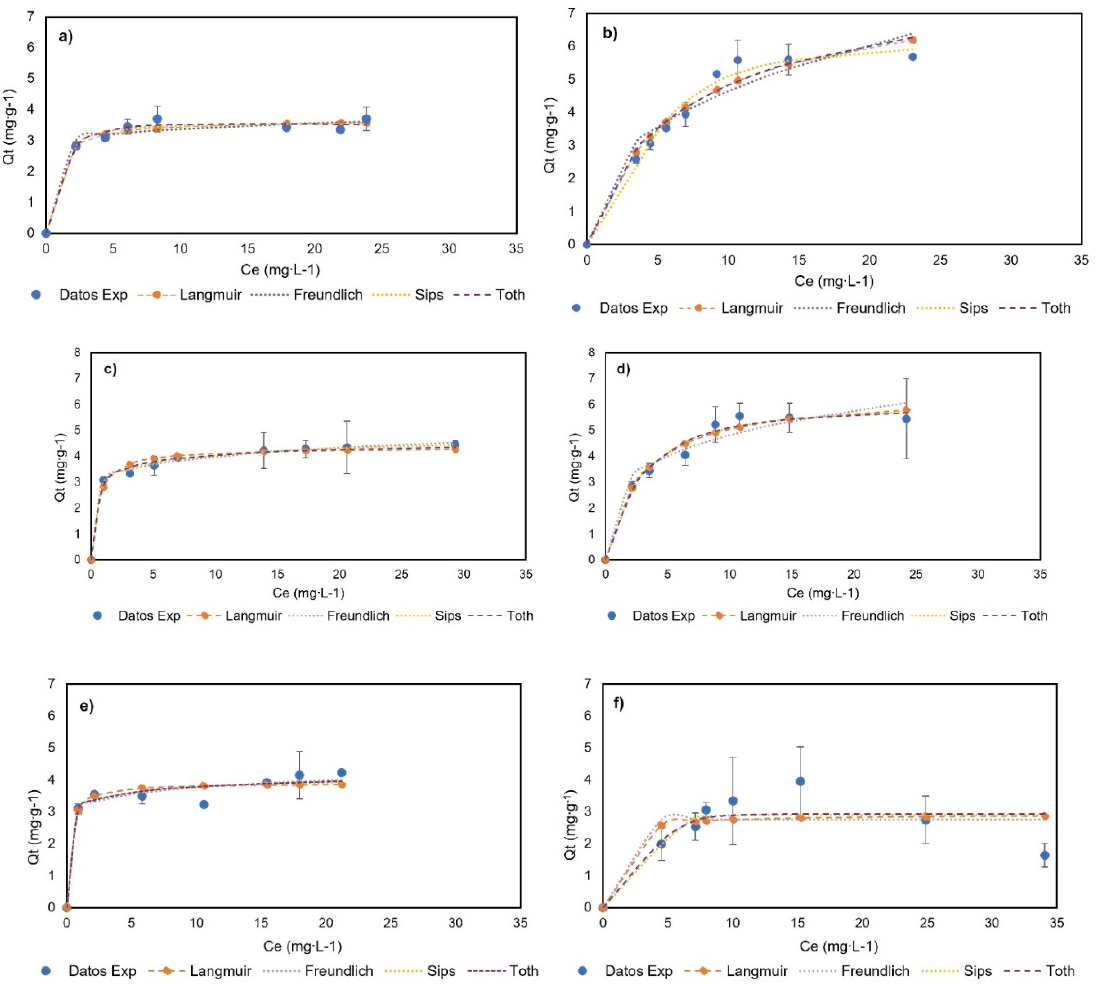
Figure 6. Adsorption isotherms of ( a ) BNC-GEN at 0 °C; ( b ) BNC-CTAB-GEN at 0 °C; ( c ) BNC-GEN